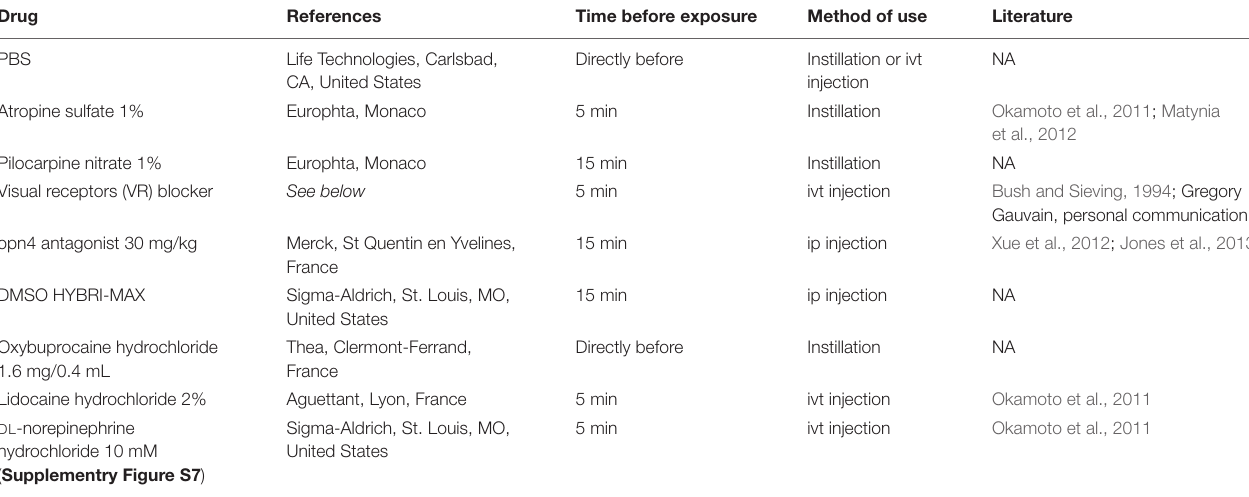
TABLE 2 | Name, manufacturer, method, and time of application (relative to the beginning of light exposure) and bibliographic reference (if